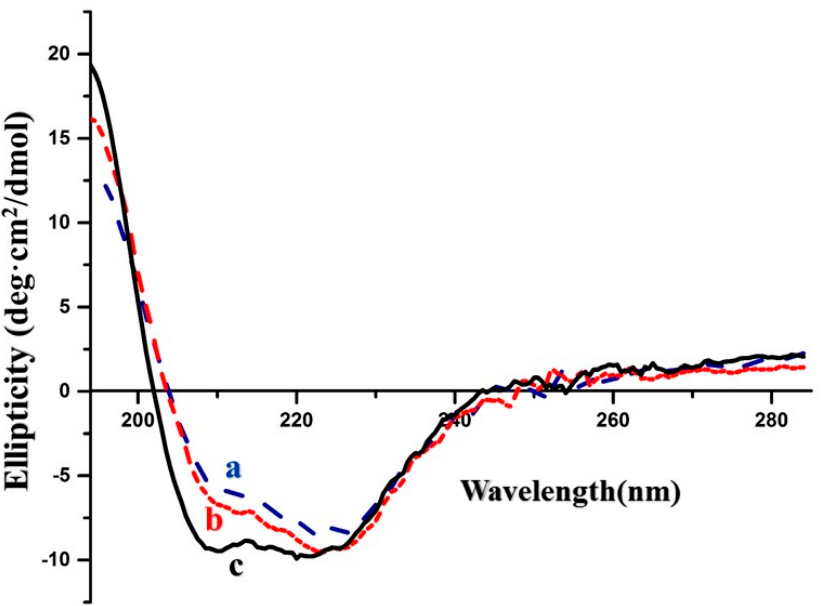
Figure 5. Circular dichroism spectra of ( a ) native rhGH solution, ( b ) dextran rhGH micro particles, ( c ) microsphere.